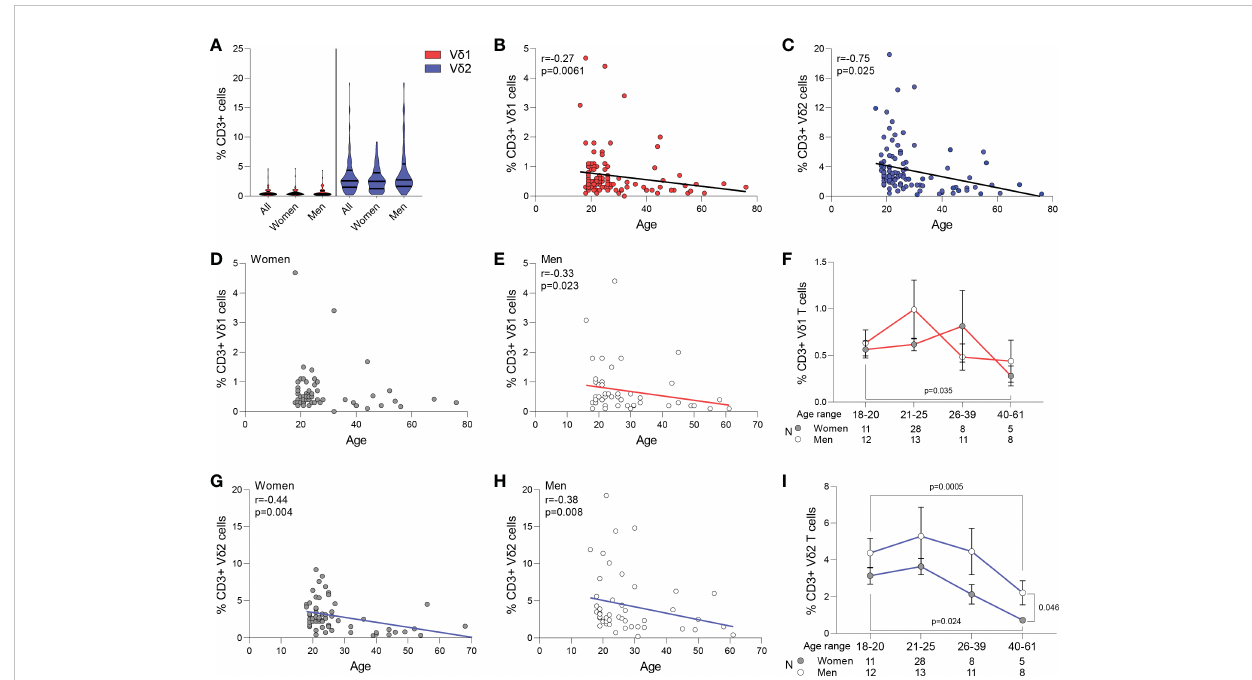
FIGURE 1 Frequency of V d 1 and V d 2 T cells. Circulating frequency of gd T cell populations in 108 healthy blood donor volunteers. (A) Violin plots show frequency of V d 1 and V d 2 T cells in the entire study cohort, with no differences between women and men. A median of 0.4% (range 0-4.4) were V d 1 T cells, and a median of 2.6% (range 0.3-19.20) were V d 2 T cells (p<0.001). Correlation of age with frequency of (B) V d 1 and (C) V d 2 T cells. (D) V d 1 T cells frequency was maintained with aging in women and (E) decreased in men. (F) Frequencies of V d 1 T cells between women and men in different ranges of age. Mean ± SEM is shown. Frequency of V d 2 T cells decreased with age in both (G) women and (H) men. (I) V d 2 T cell numbers decreased in both women and men, with a more pronounced decay in women after 40 years of age compared to men Mean ± SEM is shown. V d 1 T cells are represented in red, V d 2 T cells are represented in blue. Women are represented as fi lled circles and men as open circles. Correlation analysis by Spearman ’ s